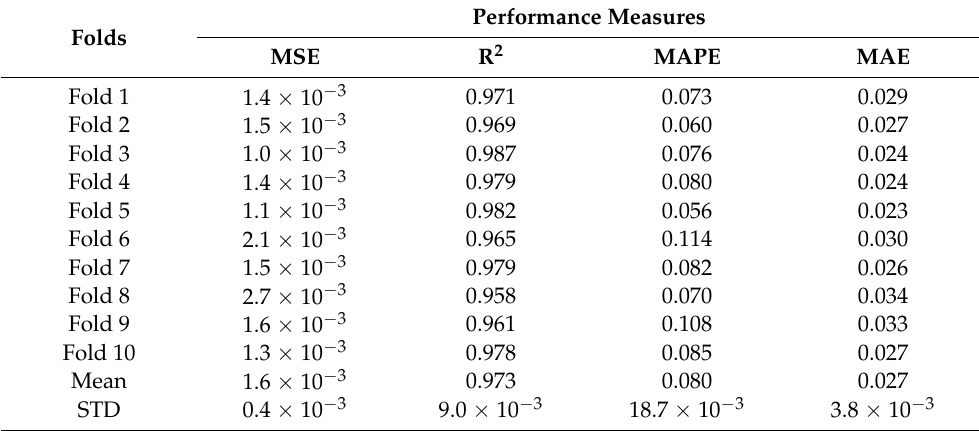
Table 4. Performance of 10-fold cross validation. Table 4. performance of 10-fold cross validation.